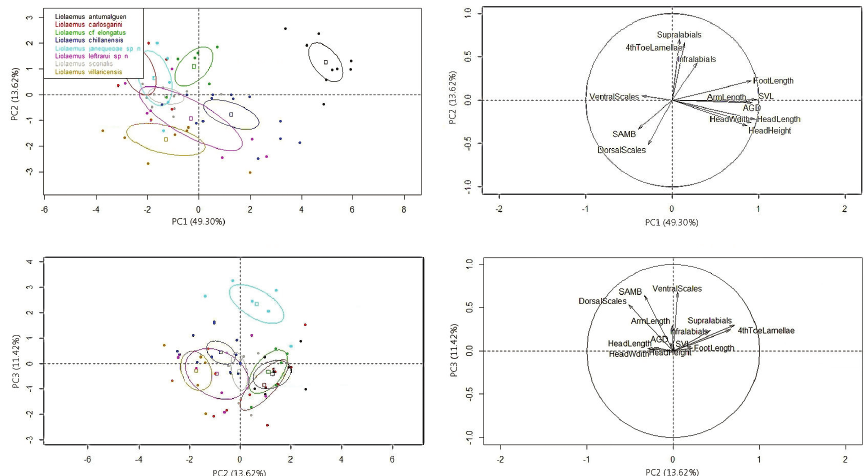
Figure 3. Principal Component Analysis (PCA) results. On the left, ellipses representing the 95% confi- dence interval around the centroid for each species. Axis correspond to the percentage of the total variance that each PC explains. On the right, contribution of each variable to the construction of the